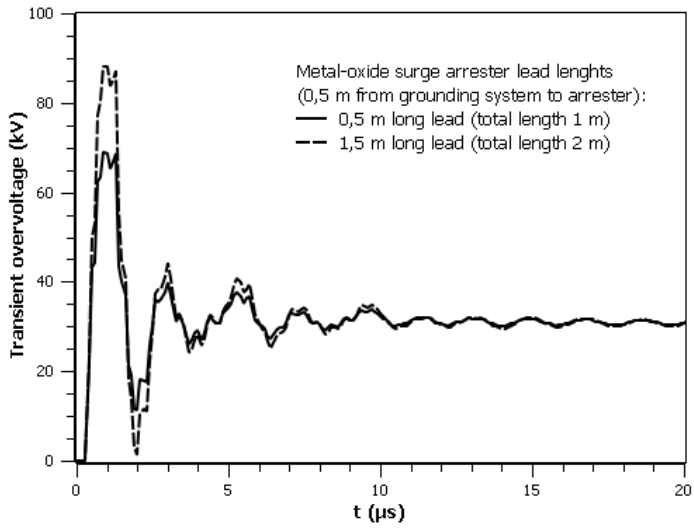
Figure 6. Influence of the arrester leads on the obtained transient overvoltages at the protected